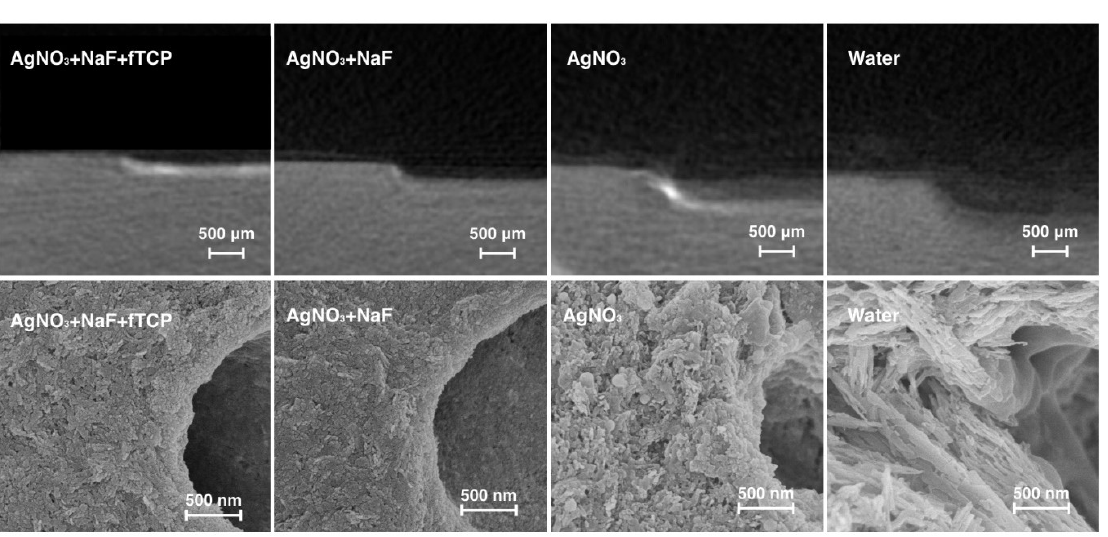
Figure 2. Typical X-ray diffraction patterns of the dentine in the four treatment groups. Figure 3 reveals the representative Fourier transform infrared spectroscopy (FTIR) spectra of the four treatment groups. The intensity of the phosphate band was strong, except in Group 4; the amide I band revealed a relatively higher peak in Group 3 and Group 4 than in Group 1 and Group 2. The mean values (± standard deviation) of amide I: HPO 42− absorbance in Groups 1 to 4 were 0.22 ± 0.05, 0.25 ± 0.05, 0.41 ± 0.12, and 0.64 ± 0.14, respectively ( p < 0.001; Groups 1, 2 < 3 < 4). The values of the ratio indicated that demineralised dentine in Group 4 had the largest amount of collagen degraded among the four groups.